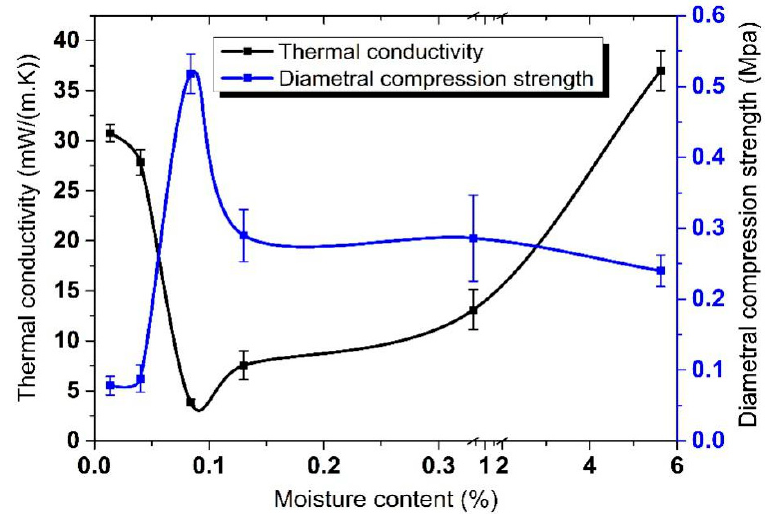
Figure 9. Relationship between thermal conductivity, diametral compression strength and moisture content.